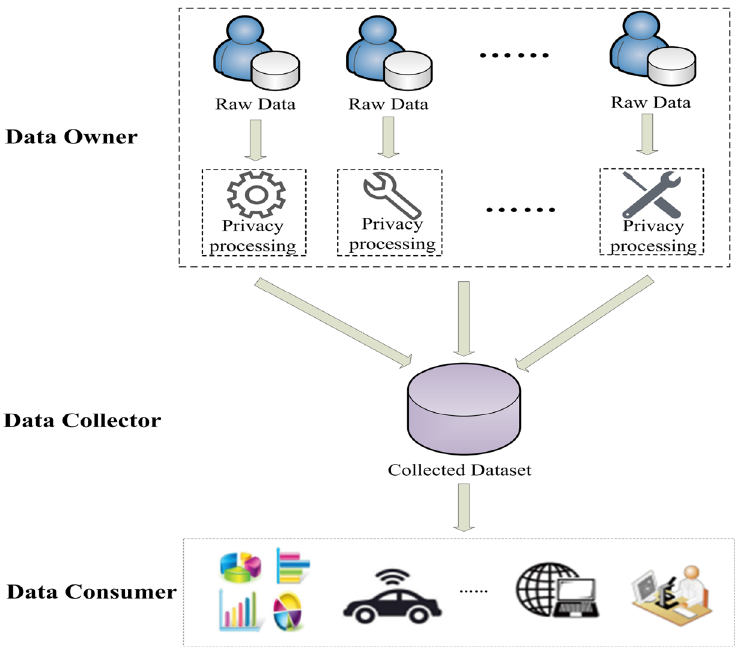
Figure 2. Data processing framework based on